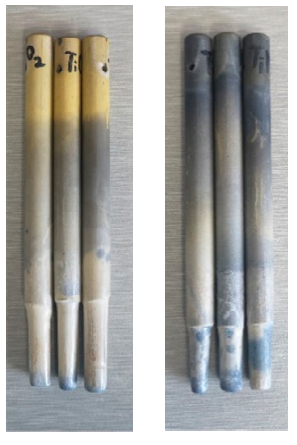
Figure 2. Treated TiO 2 and TiN rods.